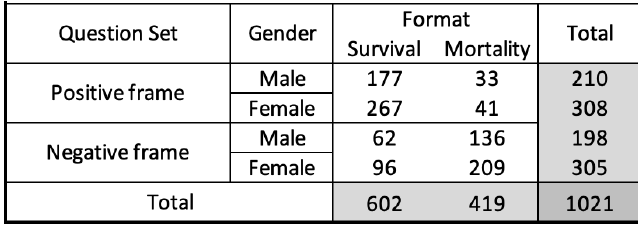
Figure 3. Respondent totals by gender.